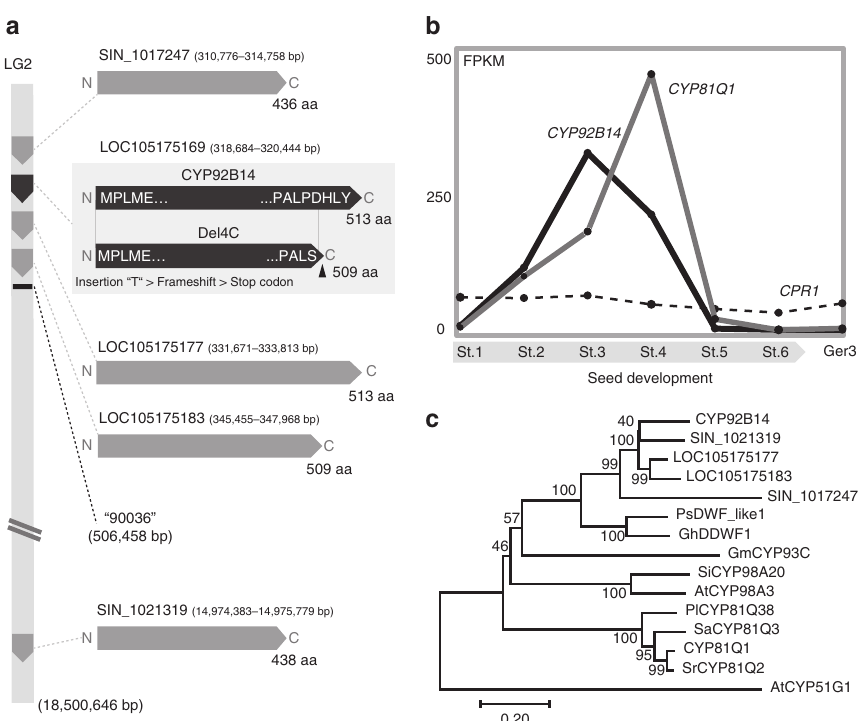
Fig. 2 Genomic structure and expression of CYP92B14. a CYP92B14, LOC105175177, LOC105175183, and SIN_1017247 are the four P450s that constitute a gene cluster in LG2. SIN_1021319 is an additional P450 similar to CYP92B14. The arrowhead indicates the position of the single-nucleotide insertion. b Gene expression analysis obtained by RNA-Seq. FPKM; fragments per Kilobase Megareads. St.; seed maturation stage 10 . Ger3; 3 days after germination. c Phylogenetics of CYP92B14 determined by the neighbor-joining method using MEGA7. Bootstrap values (1000 replicates) are shown next to the branches. Scale bar represents the rate of substitution/site